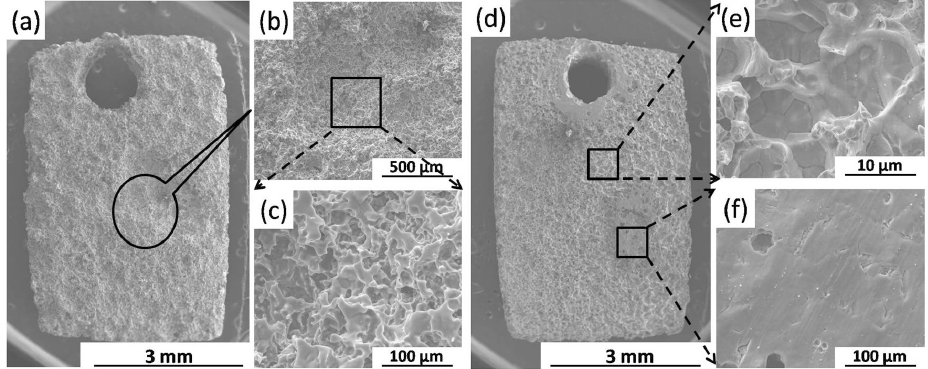
Figure 8. Surface morphologies of ( a – c ) the BM and ( d – f ) the FSP specimens after immersion for one day (without corrosion products).